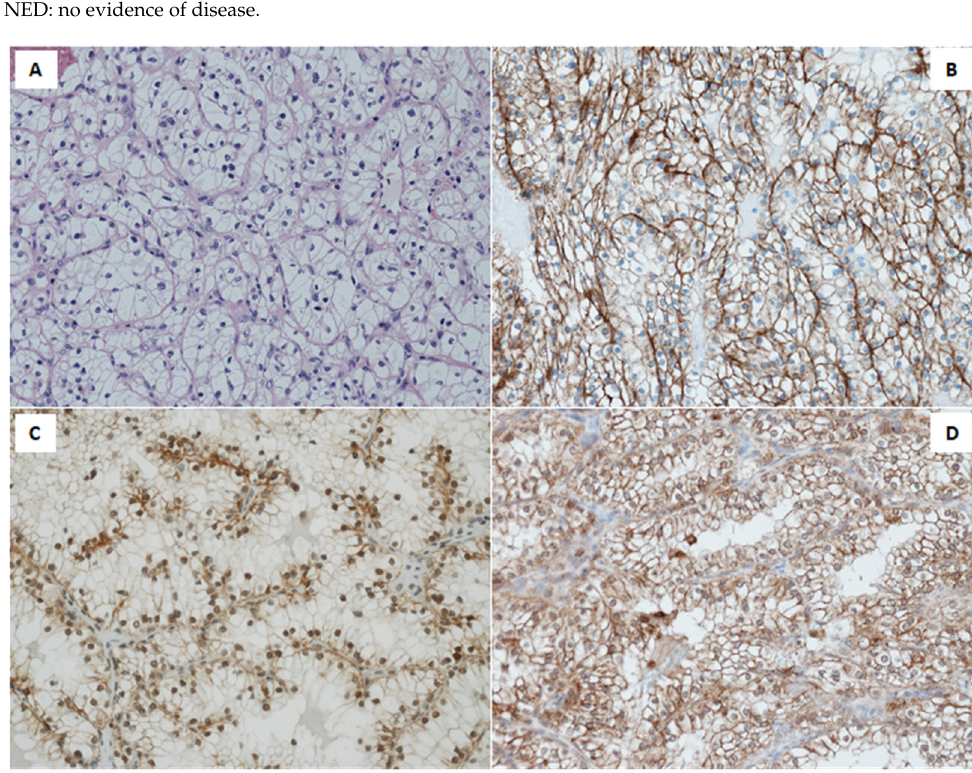
Figure 1. Morphologic and immunohistochemical features of Clear Cell Renal Cell Carcinoma. ( A ) Hematoxylin and Eosin stain shows typical CCRCC morphologic features; ( B ) Immunohistochemistry for EGFR (clone 2-18C9) displaying diffuse and intense membranous immunoreactivity; ( C ) Immunohistochemistry for EGFR (polyclonal sc-03) displaying intense nuclear immunoreactivity; ( D ) Immunohistochemistry for SGLT1 on CCRCC showing diffuse and intense, predominantly membranous immunoreactivity).